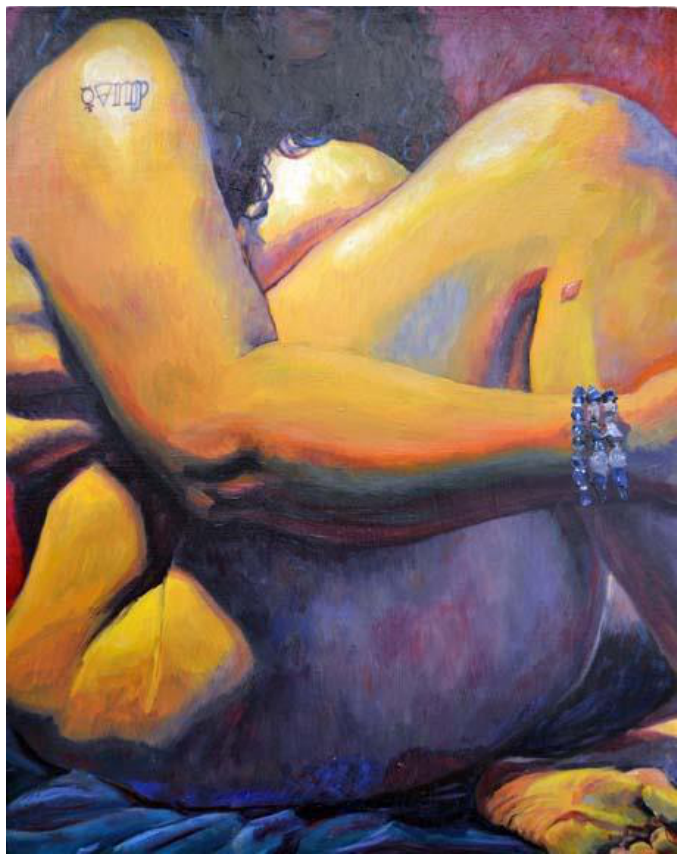
Cecelia Ivy Price, Coming to Confidence I, 2014, Oil on